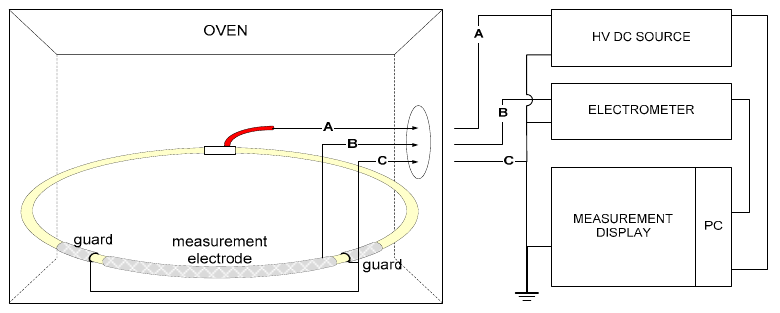
Figure 5. Conduction current measurement setup.